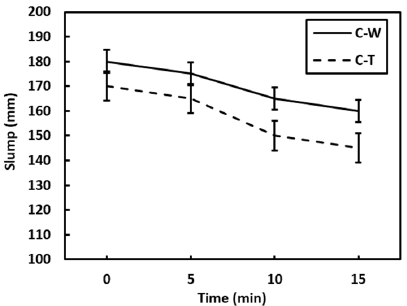
Figure 9. The slump of concrete (C-W group vs. C-T group).